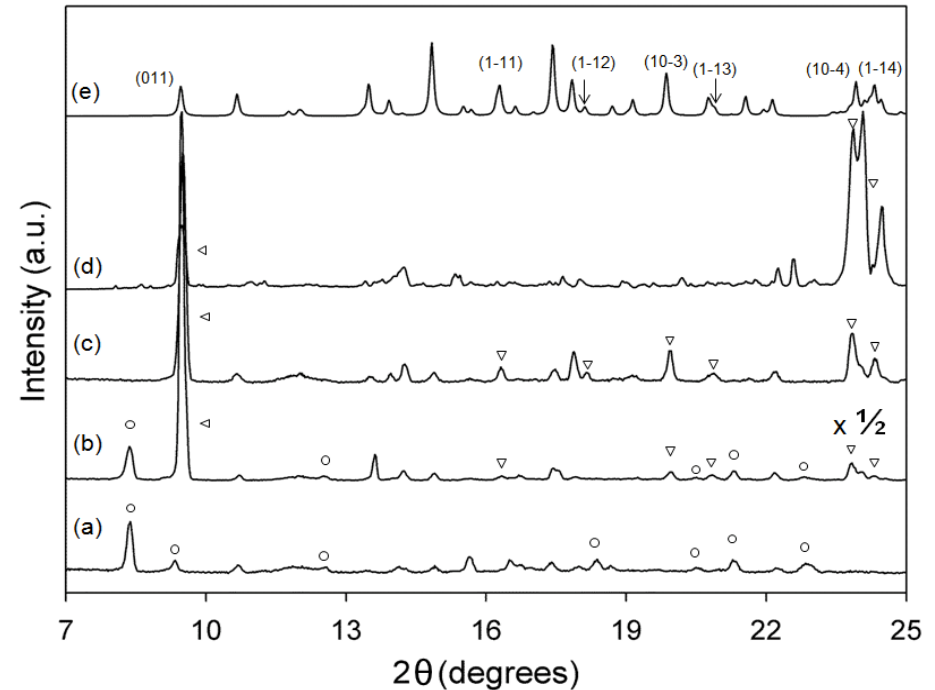
Figure 4. XRD patterns of AD/SUC cocrystals, prepared by the precipitation from the AD/SUC = 2:1 solutions: ( a ) form I prepared with PAA; ( b ) form I + II collected after 1 day without additive (Intensity was reduced to half (  1/2) for easy